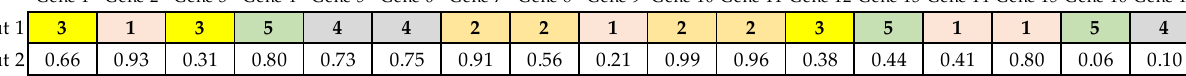
Figure 2. Illustration of an alpha chromosome.